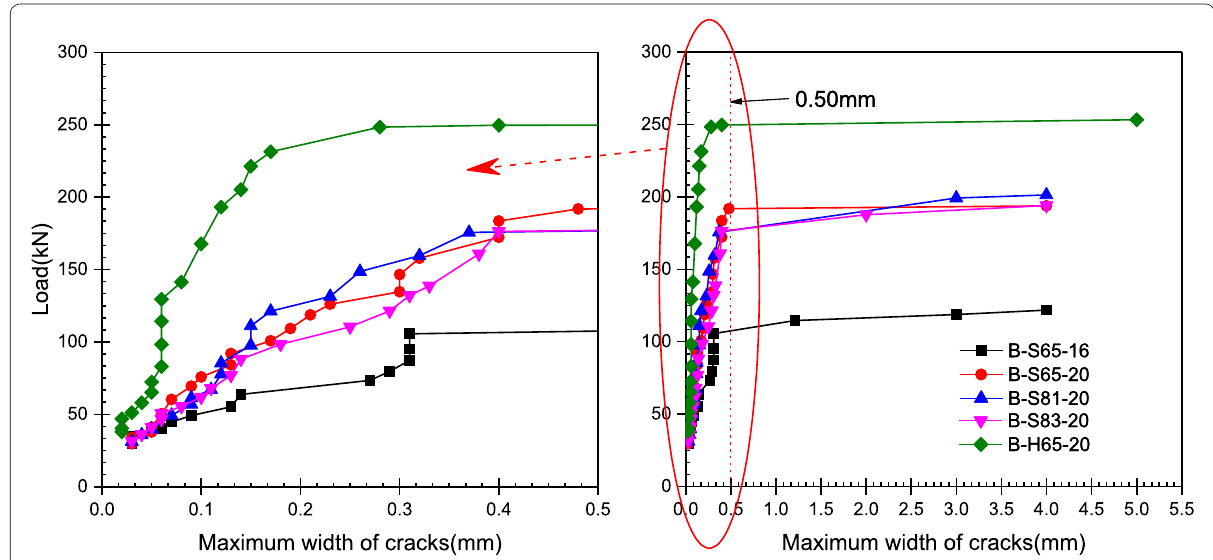
Fig. 17 Load-maximum crack width curves of specimens.